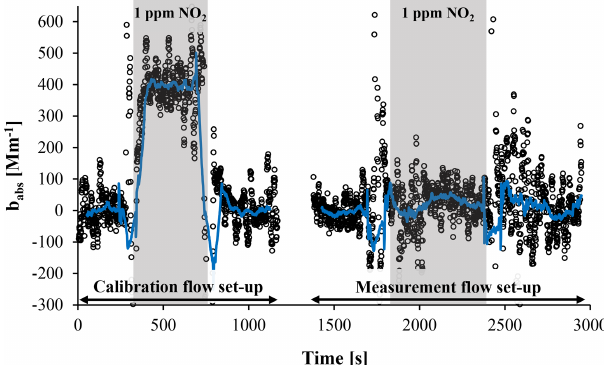
Figure 10. Demonstration of the relative nature of the MSPTI mea- surement. Circles represent averages over 10s, whereas the blue line is the 100s moving average. In the measurement flow configura- tion, NO 2 is present in both sample and reference chambers and no longer contributes to the MSPTI